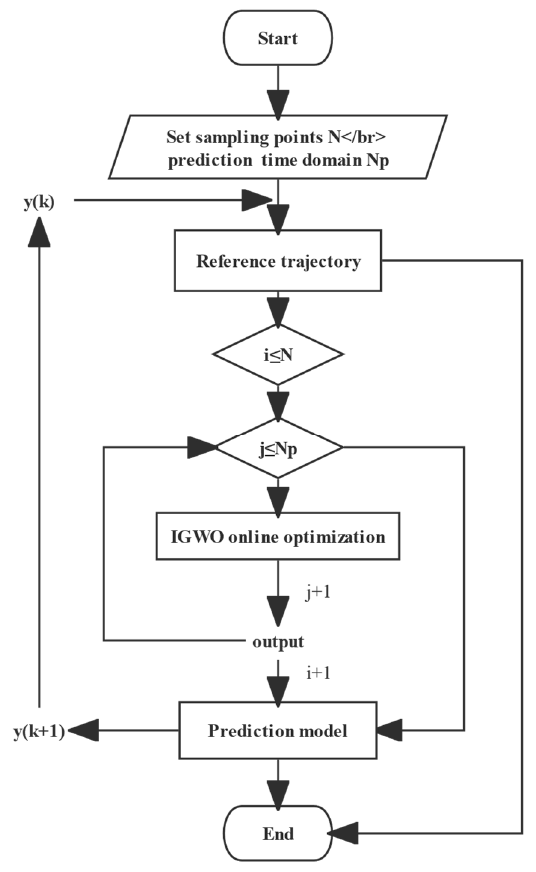
Figure 4. The flowchart of proposed nonlinear model predictive controller.